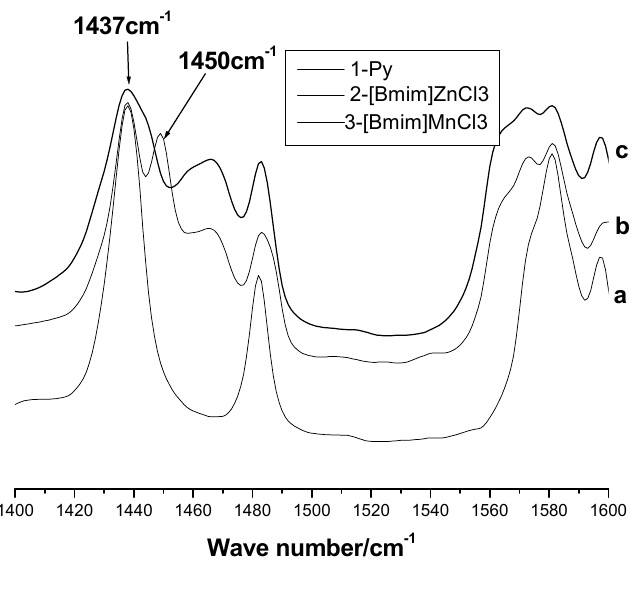
Figure 5. FTIR spectra of: ( a ) pure pyridine; ( b ) pyridine and [Bmim]ZnCl ( c ) pyridine and [Bmim]MnCl